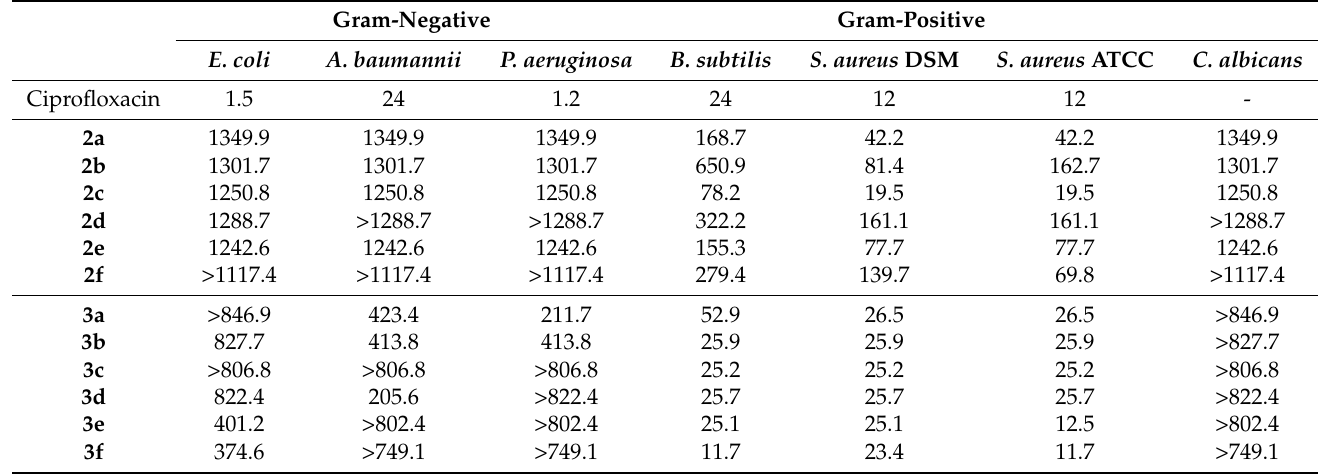
Table 1. MIC values ( µ M) against Gram-negative bacteria ( E. coli DSM 30083, A. baumannii , P. aeruginosa ), Gram-positive bacteria ( B. subtilis 168, S. aureus DSM 20231, S. aureus ATCC 43300), and C. albicans DSM 1386. Gram-Negative